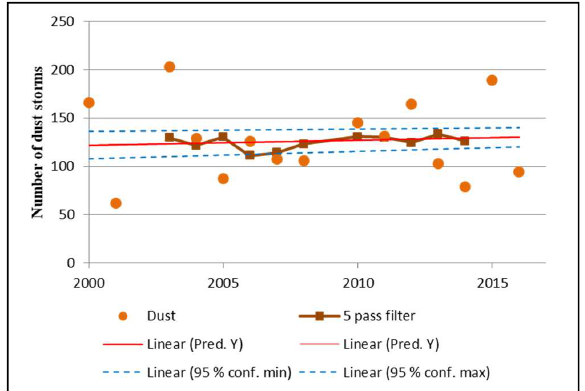
Figure 3. Temporal trend analysis of the total annual number of dust storm events as recorded over all the in situ stations across entire Saudi Arabia between the years 2000 and 2016, including a five-pass filter and linear regression line with associated model error bounds (at 95% confidence interval).